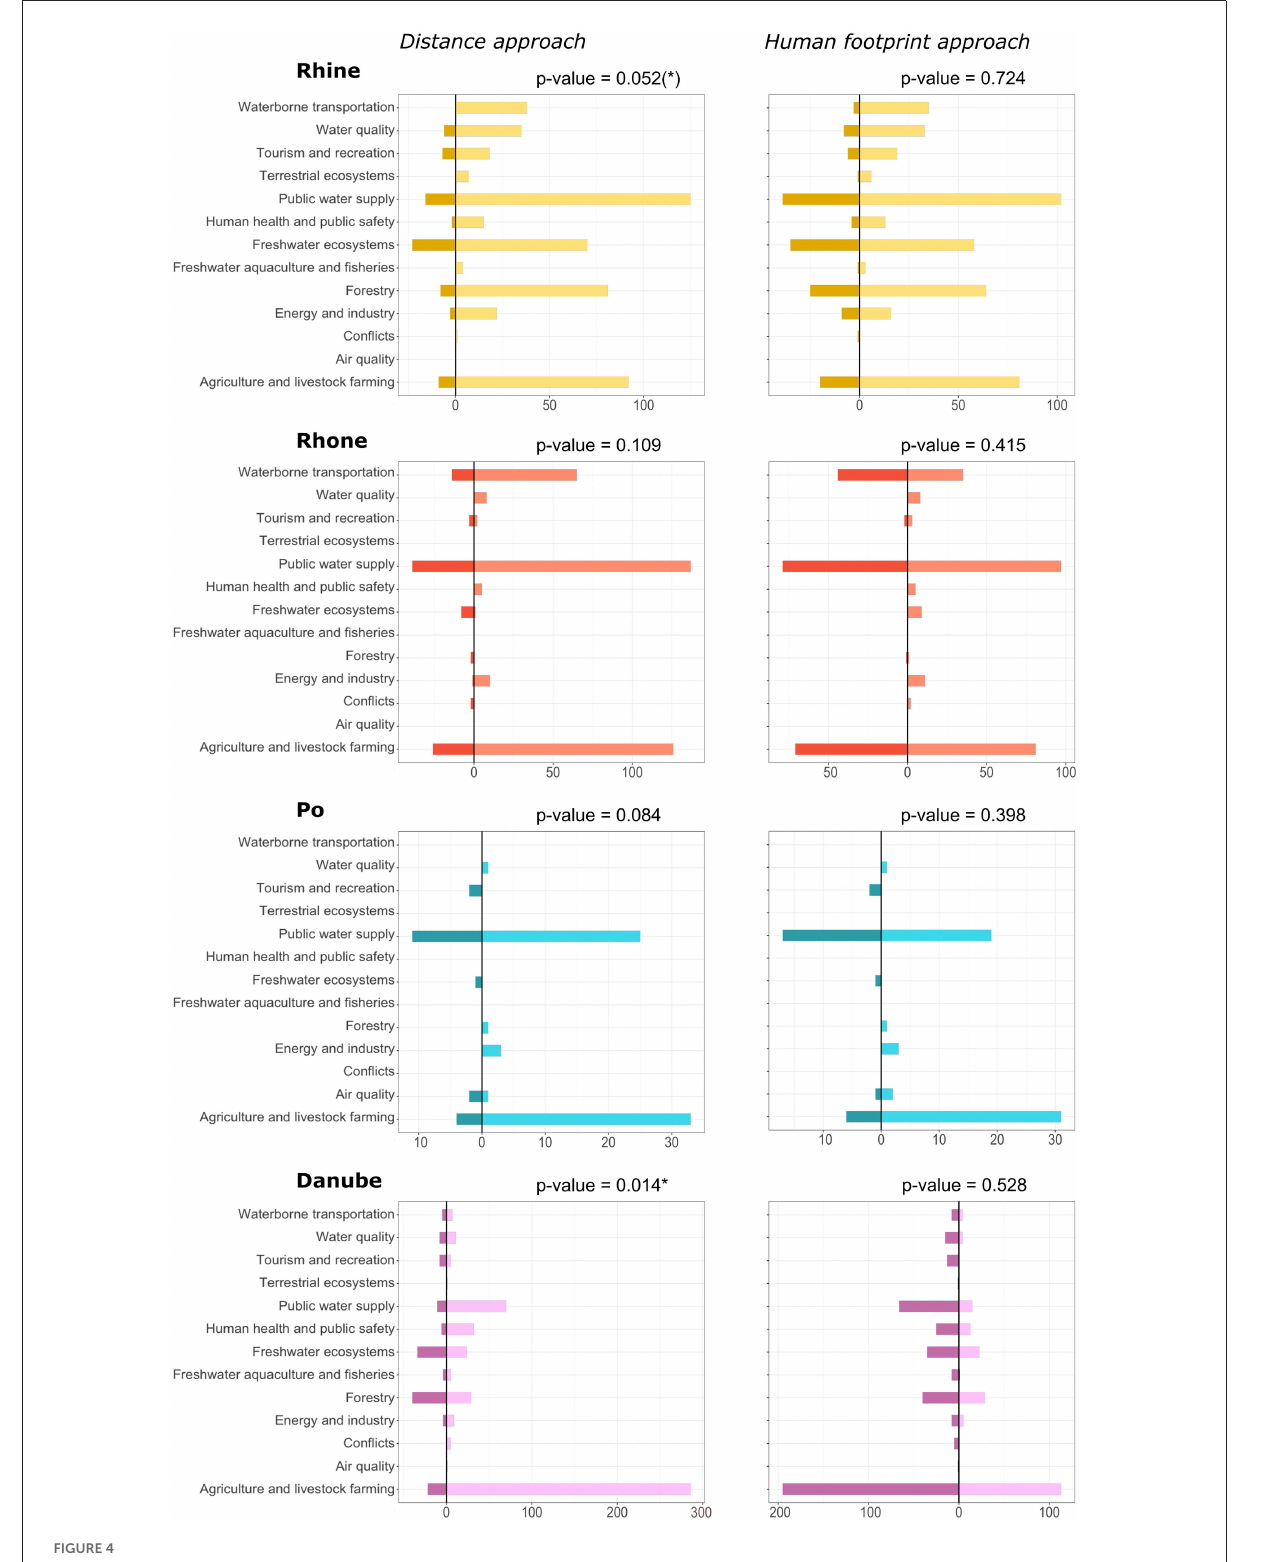
FIGURE4 Distribution of drought impacts by impact category in upstream (darker color) and downstream (lighter color)